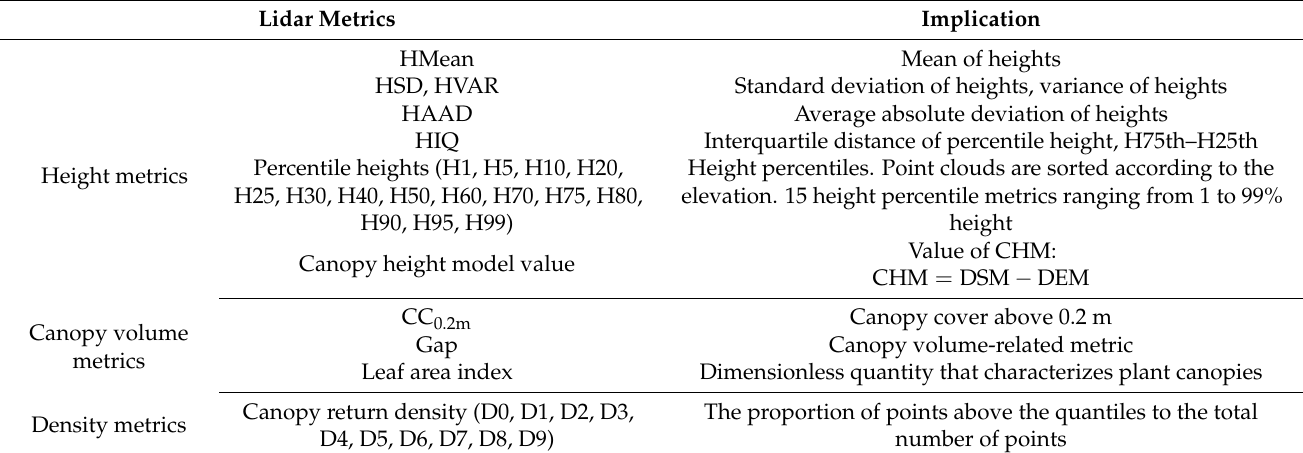
Table 1. List of metrics derived from UAV lidar point clouds.